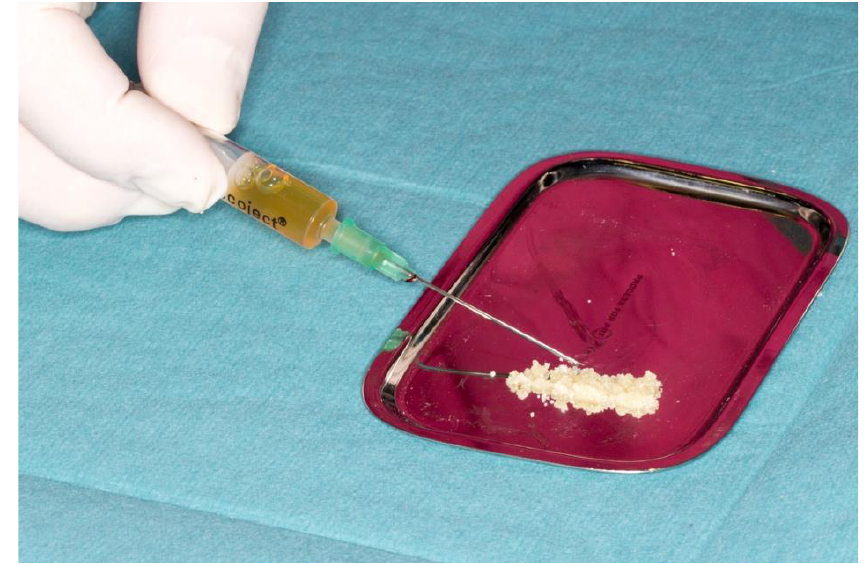
Figure 2. “Sticky tooth” (ground dentin mixed with i -PRF).